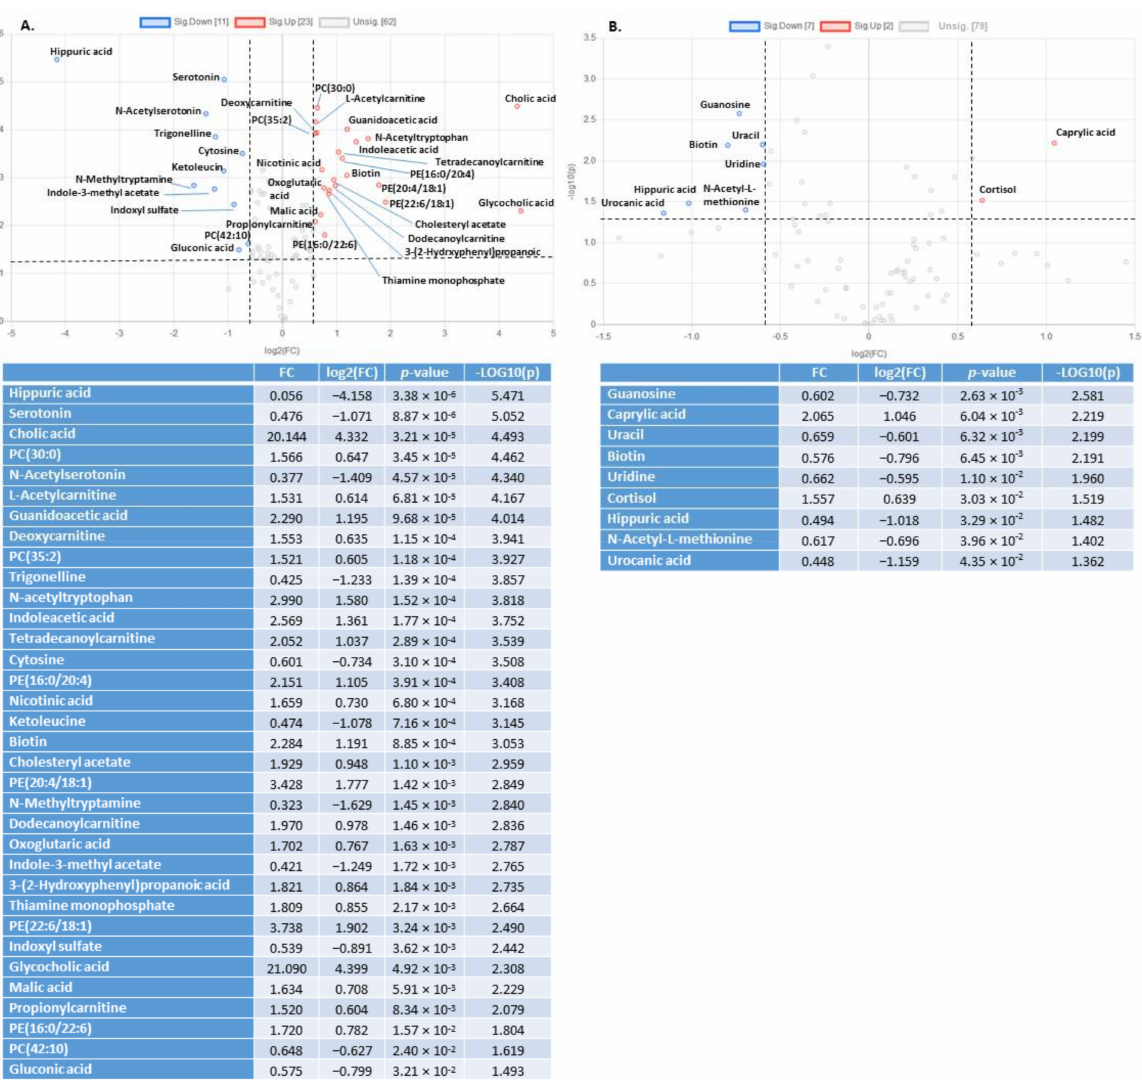
Figure 2. Volcano plots showing metabolites changes in serum ( A ) and soleus ( B ) in Klf10 KO versus WT. Each point corresponds to a metabolite (as VIP). Significant selected metabolites are upregulated in red and downregulated in blue. In grey, metabolites with 0.5 < FC < 1.5 and/or p -value > 0.05. Dotted horizontal line indicates threshold for p -value of 0.05 and the dotted vertical line indicates threshold for 1.5 fold change